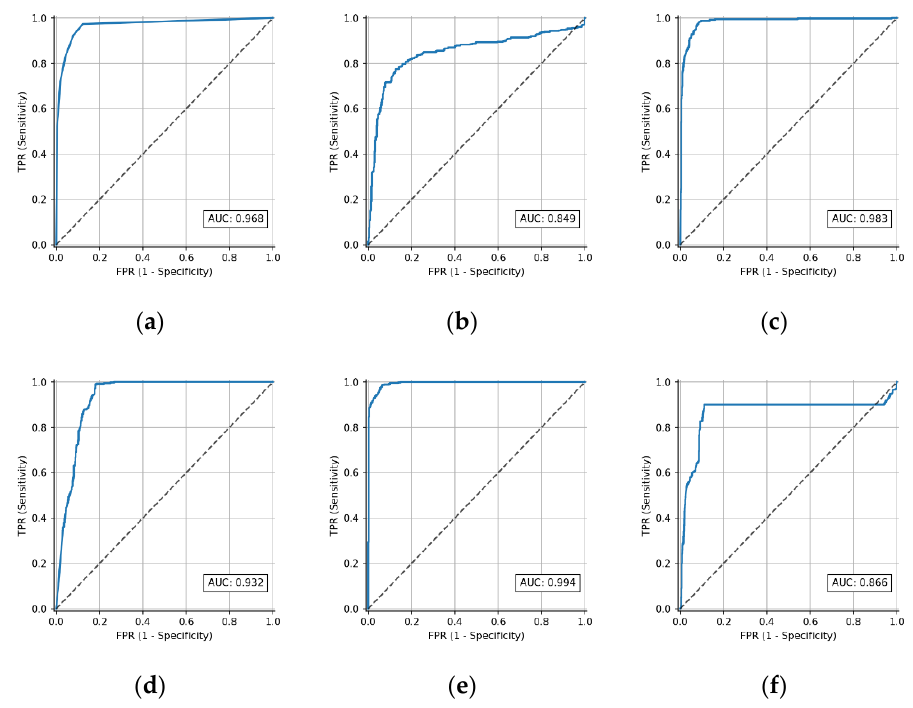
Figure 3. Performance of the 6 classification models considered at all classification thresholds (ROC curves): ( a ) k -nearest neighbors, ( b ) logistic regression, ( c ) multi-layer perceptron, ( d ) naïve Bayes, ( e ) random forest and ( f ) support vector machines.